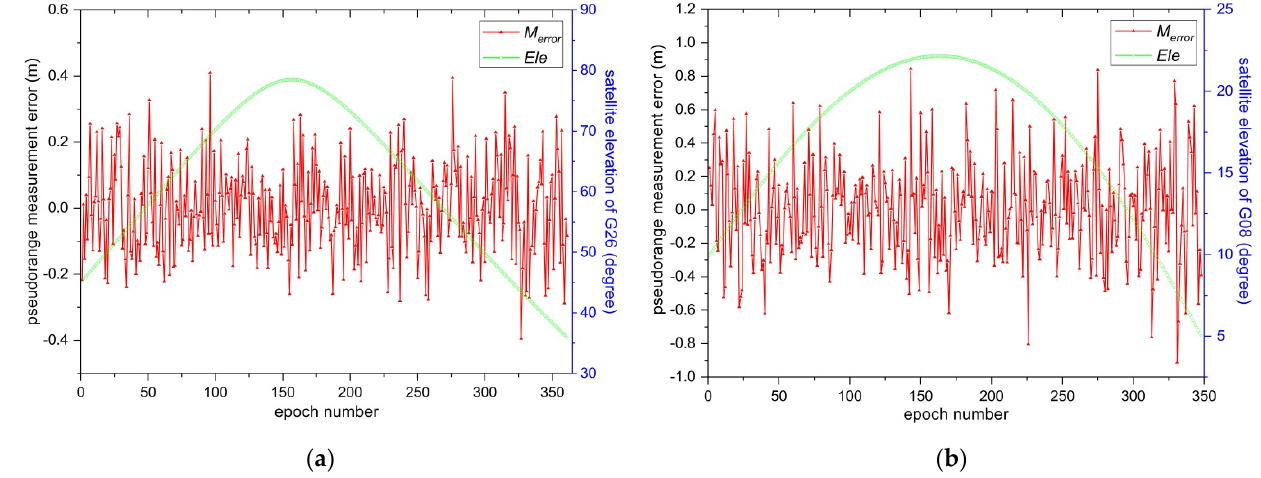
Figure 1. ( a ) Elevation and pseudorange measurement error sequence of satellite G26; ( b ) elevation and pseudorange measurement error sequence of satellite G08.